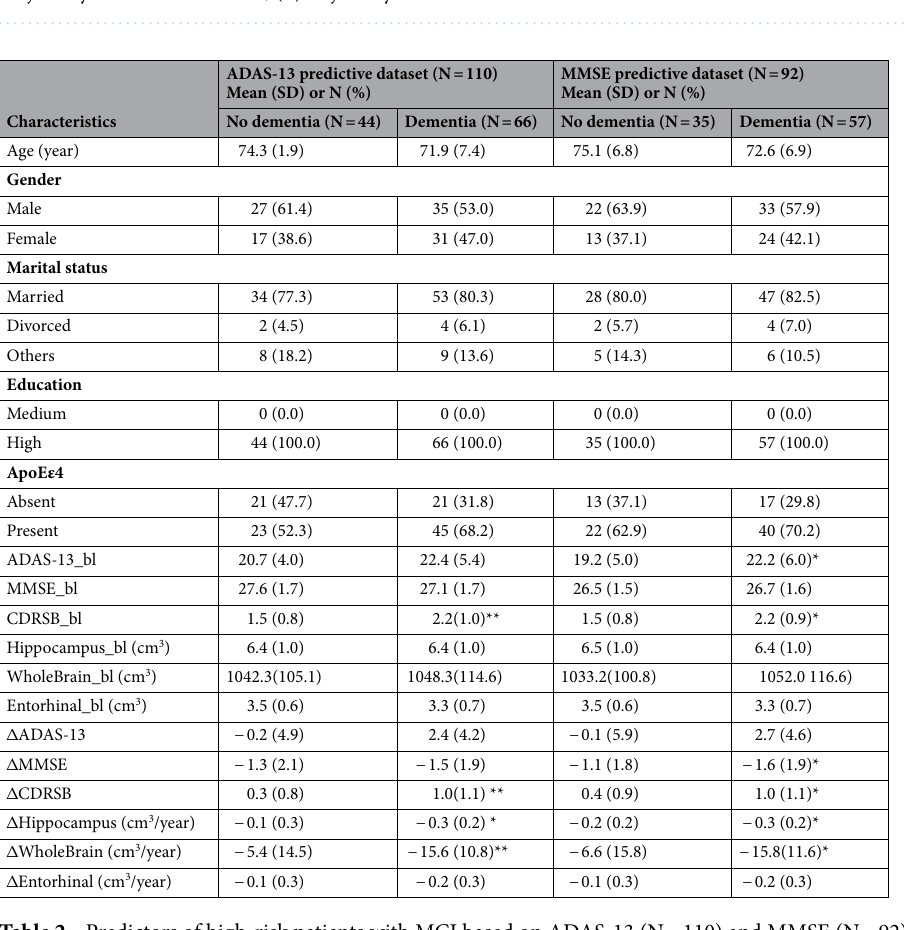
Figure 1. Clinical score distributions at each timepoint for the different trajectories derived from the K-means clustering (N = 85). The mean scores at each timepoint are used to build a template for each trajectory class. ( a ) Trajectory based on ADAS-13; ( b ) trajectory based on MMSE.